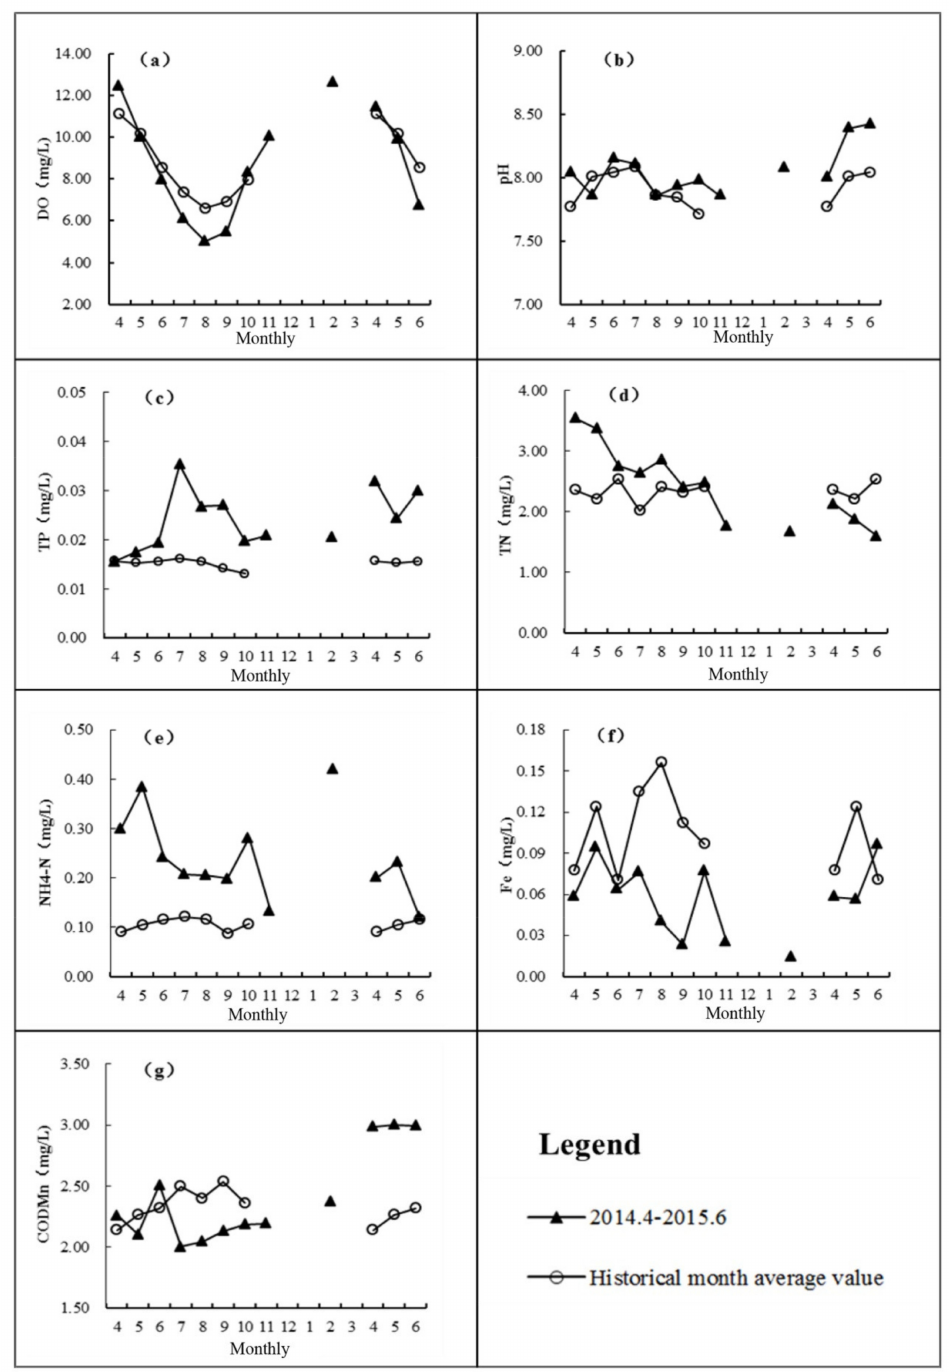
Figure 5. The monthly change of DO ( a ), pH ( b ), TP ( c ), TN ( d ), NH4-N ( e ), Fe ( f ), and CODMn ( g ) in Biliuhe